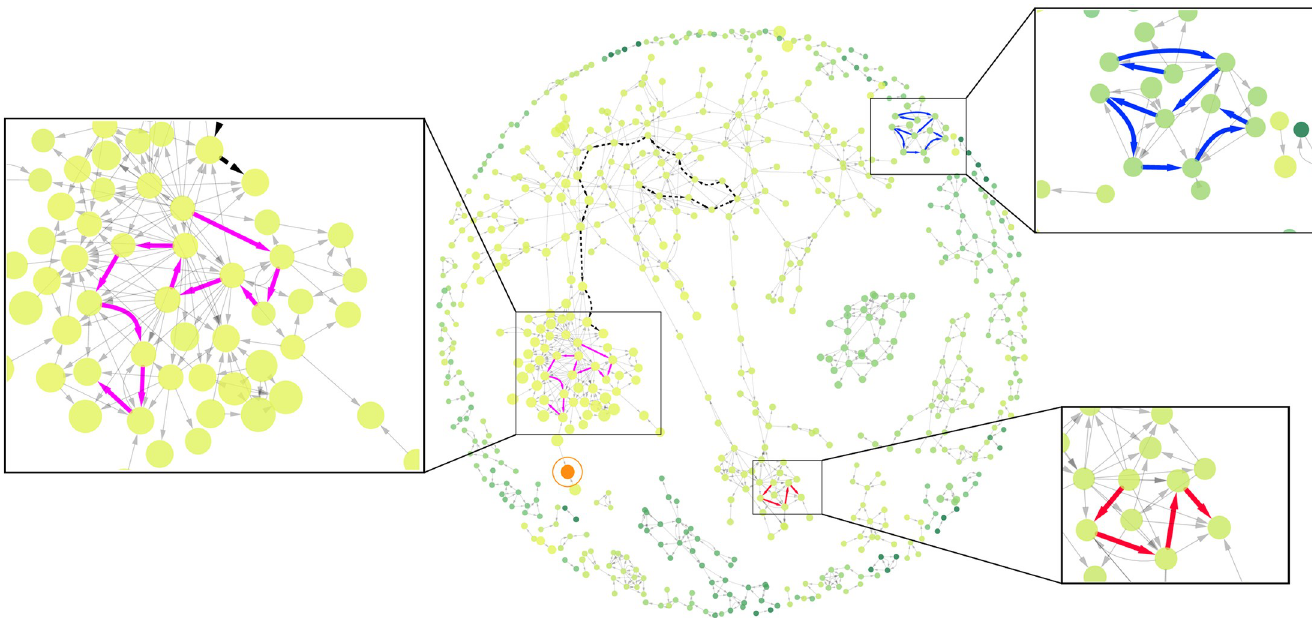
Fig 2. The directed network based on genetic and temporal distances between MLVA profiles, where each directed edge is obtained from Bayesian inference. The network comprises 690 connected nodes and 1,020 directed edges, with each node representing an MLVA profile and each edge representing an inferred evolutionary step. In addition, each profile may be associated with a cluster of other profiles within a genetic distance G . Formally, the cluster C i associated with node i is given by C i = { j : G ij � G max }, for some threshold G max (Materials and methods). The size of the nodes represents the average prevalence within this cluster approximating the average virulence across closely related strains. In this network, the node associated with the most prevalent cluster (profile 3-9-7-17-523) is highlighted and circled in orange. The color of all other nodes illustrates their genetic distance to this reference node, from light green (closest) to dark (farthest). The layout of nodes is given by Cytoscape’s edge-weighted spring-embedded algorithm, which groups together cliques of nodes. From this graph, we can capture a potential evolutionary path between two connected nodes as a sequence of directed edges between them, as described in Model. We highlight three case studies as paths in magenta, blue, and red that contain eleven, nine, and five STM strains respectively. These paths include profiles associated with outbreaks previously investigated by the Australian Department of Health (see Materials and methods). The path shown in magenta includes (as the 9th node) profile 3-10-7-14-523, which caused a significant outbreak in October 2013. The origin node of the blue path is profile 3-12-9-10-550, which was the source of an outbreak in January 2011. The origin profile of the red path is 3-16-9-11-523, which is associated with at least two outbreaks in February 2014 and September 2015. In addition to the case studies above, we illustrate the longest path (17 nodes) inferred from the dataset as a dashed black line with a source node near the top-left of the network. The origin of this path is profile 3-12-9-12-523, which was consistently detected from January 2008 to November 2016, spanning the entire dataset.